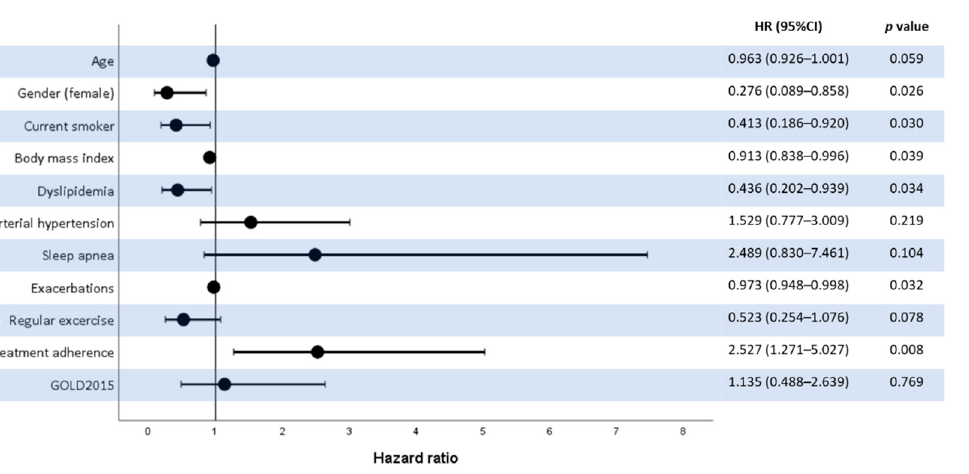
Figure 1. Forest plot showing the results of the Cox proportional hazard regression of factors associated with being a responder to single bronchodilation as a treatment for COPD. Note: HR—hazard ratio; CI—confidence interval.